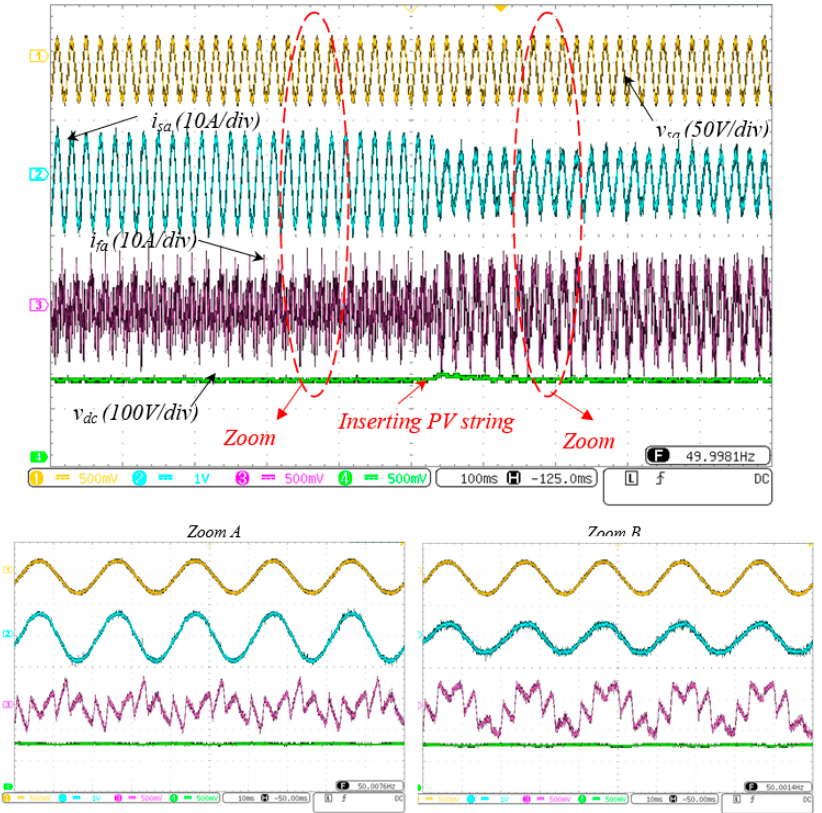
Figure 19. Voltage, current, active power of the main source and PV string at PV system switch ON. Energies 2018 , 11 , x FOR PEER REVIEW